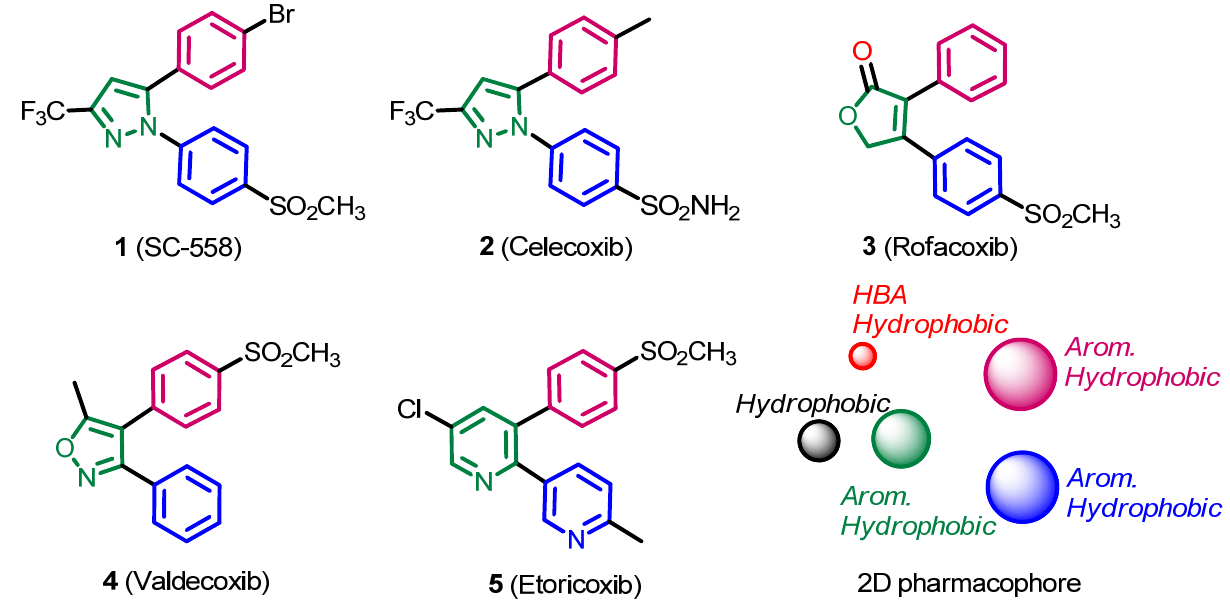
Figure 1. Coxibs 1–5 and a 2D pharmacophore generated based on their chemical structures.